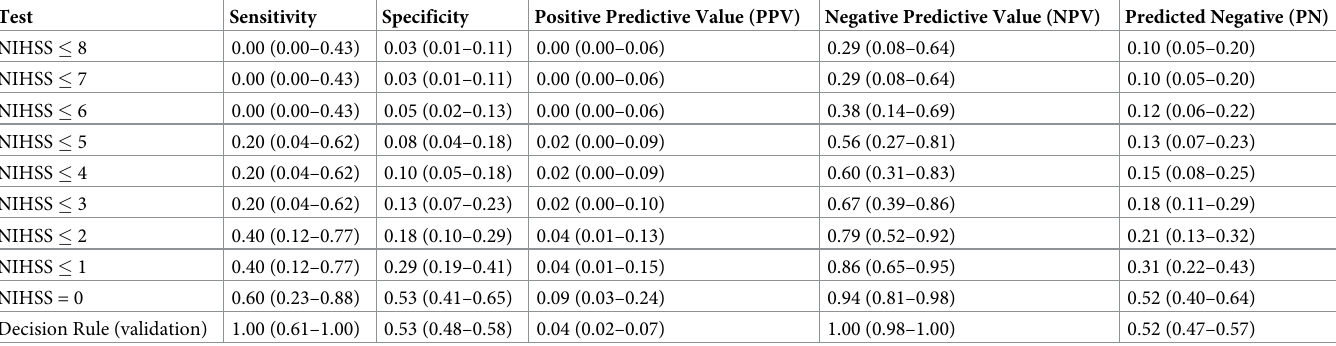
Table 3. NIHSS and decision rule performance.